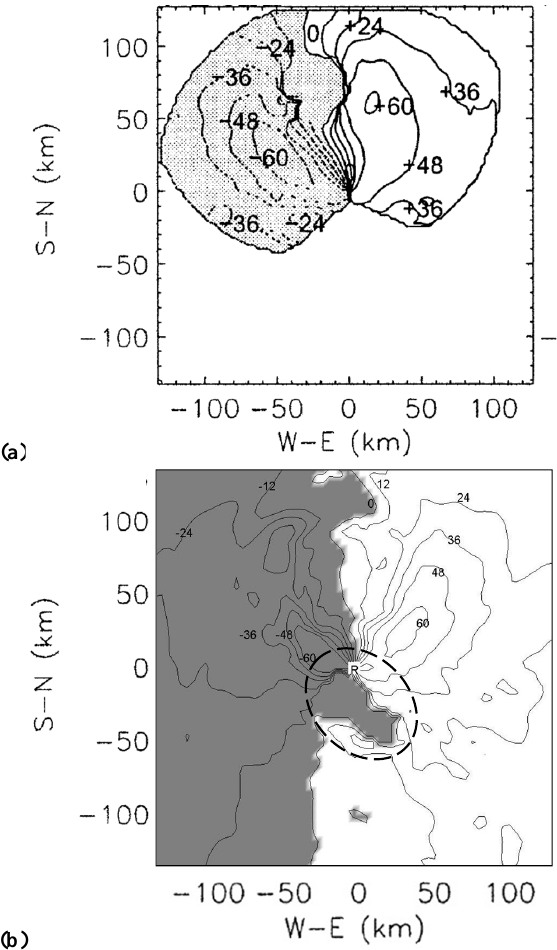
Fig. 5. (a) Time series of the maximum wind velocity (ms − 1 ) at 1000m altitude for the “ Ocean ” and “ Island ” from 3 to 33h (at 3-h interval); (b) as in (a) , except for minimum sea level pressure (MSLP) (hPa); (c) as in (a) , except for the ratio between major and minor axes of the eye from 14 to 27h (1h interval). Grey lines indi- cate trend of the ratio (polynomial approximation, 6th order).